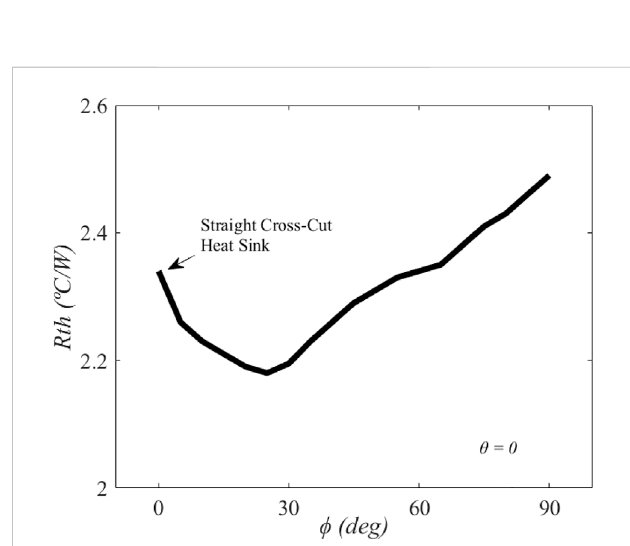
FIGURE 10 Effect of the inclined fi n angle (R TH : Thermal Resistance) (Park and Lee, 2017).